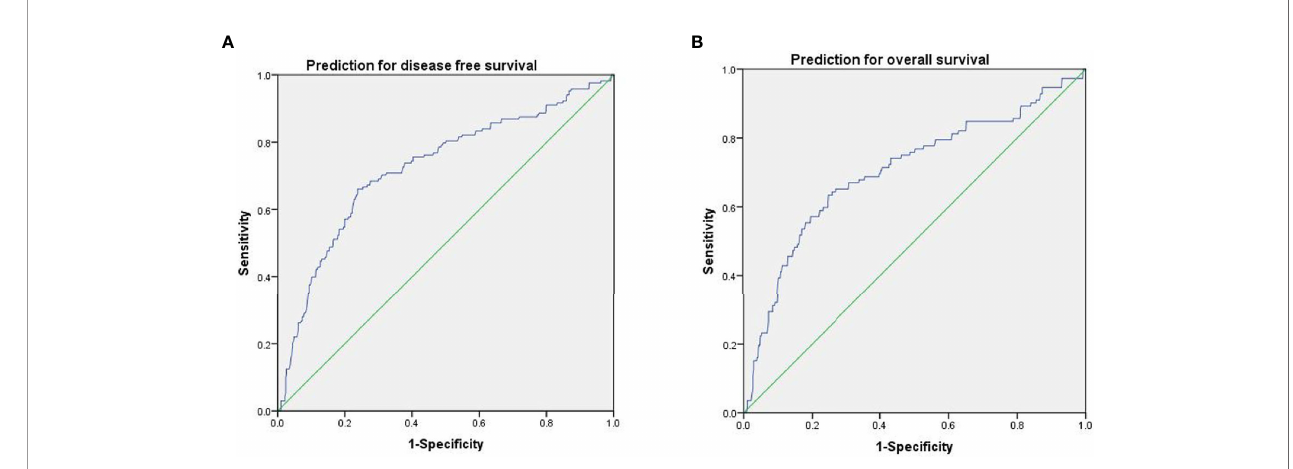
FIGURE 2 | ROC curves of SII for predicting DFS (A) and OS (B) .